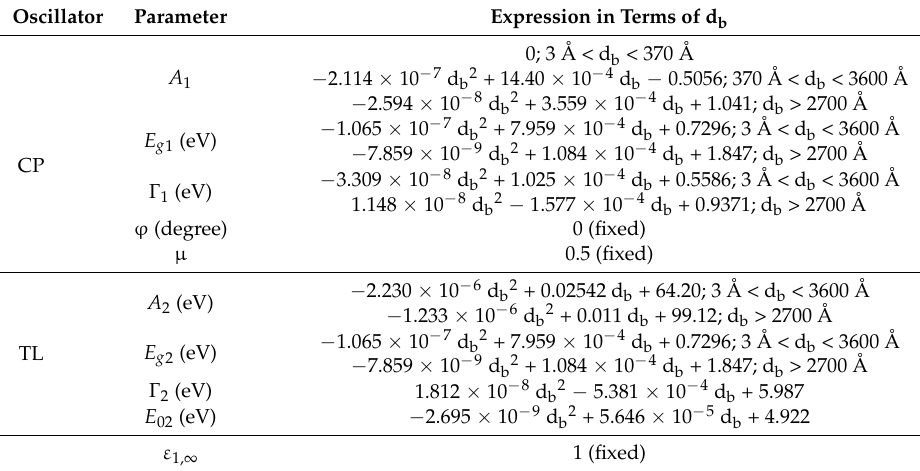
Table 5. Second-order polynomial expressions for the critical point (CP) and Tauc-Lorentz (TL) oscillator parameters of the ( ε 1 , ε 2 ) spectra for (In 1 − x Ga x ) 2 Se 3 with x = 0.30, given in terms of the bulk layer thickness d b . For all parameters with the exception of Г 2 and E 02 , two different ranges of d b are used as indicated for describing the polynomial. Among the ten possible variable parameters in an expression that combines CP and TL oscillators, three ( ϕ , µ , ε 1, ∞ ) are fixed as shown and two ( E g 1 , E g 2 ) are coupled. Thus, the bandgap of the TL oscillator E g 2 is equated to the fundamental bandgap E g 1 , which is the resonance energy of the CP oscillator. When the CP amplitude is strong, the CP oscillator controls the absorption onset; however, when the CP is very weak, the TL oscillator controls the onset. Oscillator Parameter Expression in Terms of d